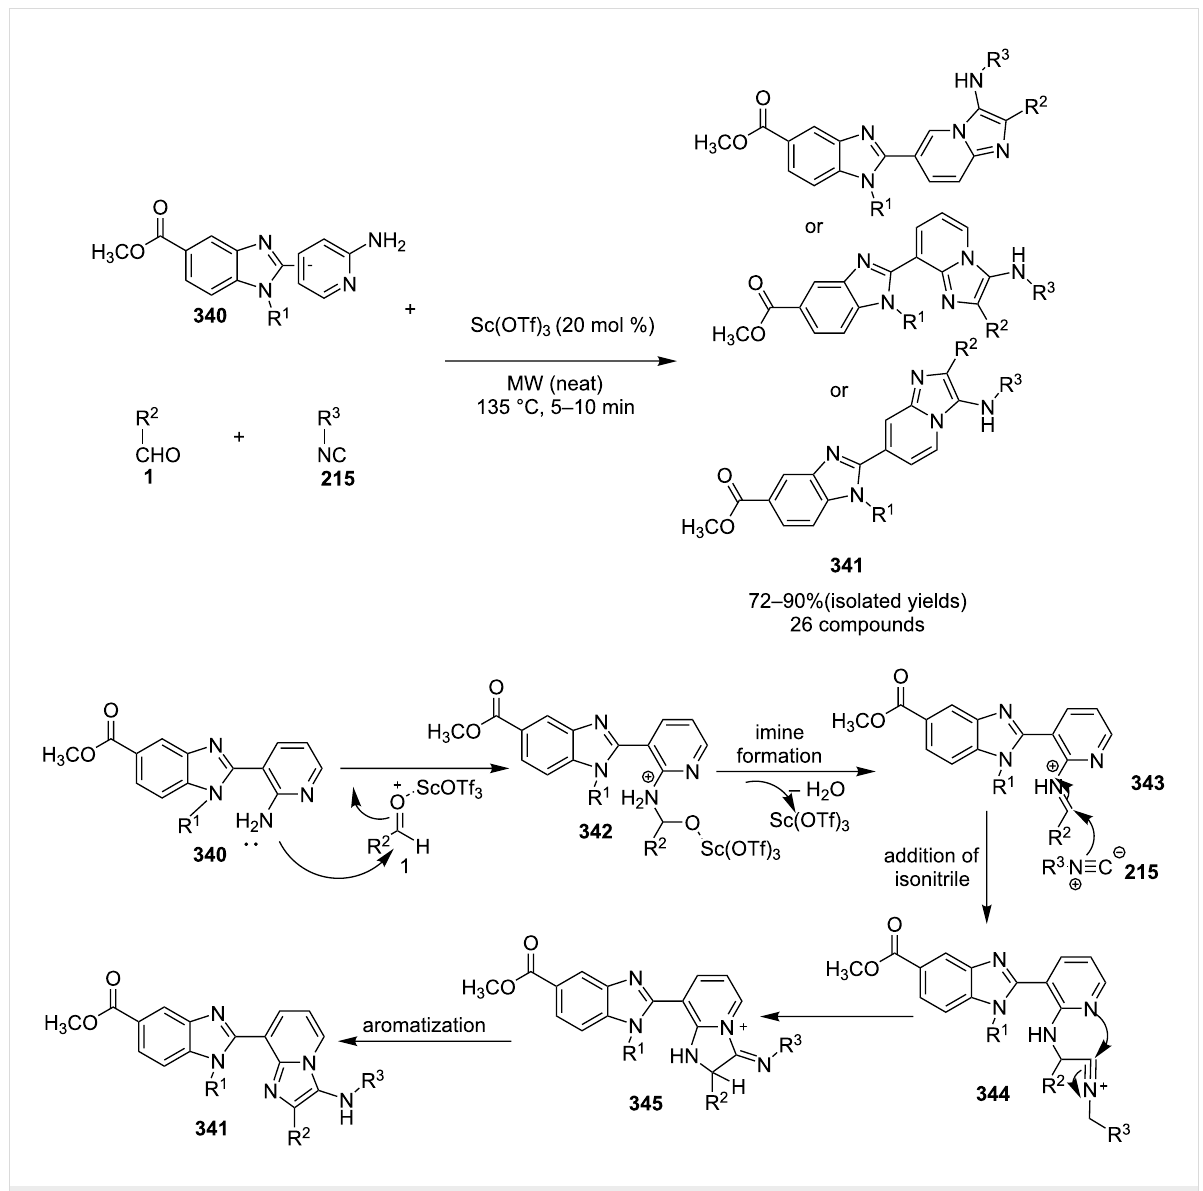
Scheme 112: Scandium(III)triflate-catalyzed one-pot reaction and its mechanism for the synthesis of benzimidazolylimidazo[1,2- a ]pyridines.